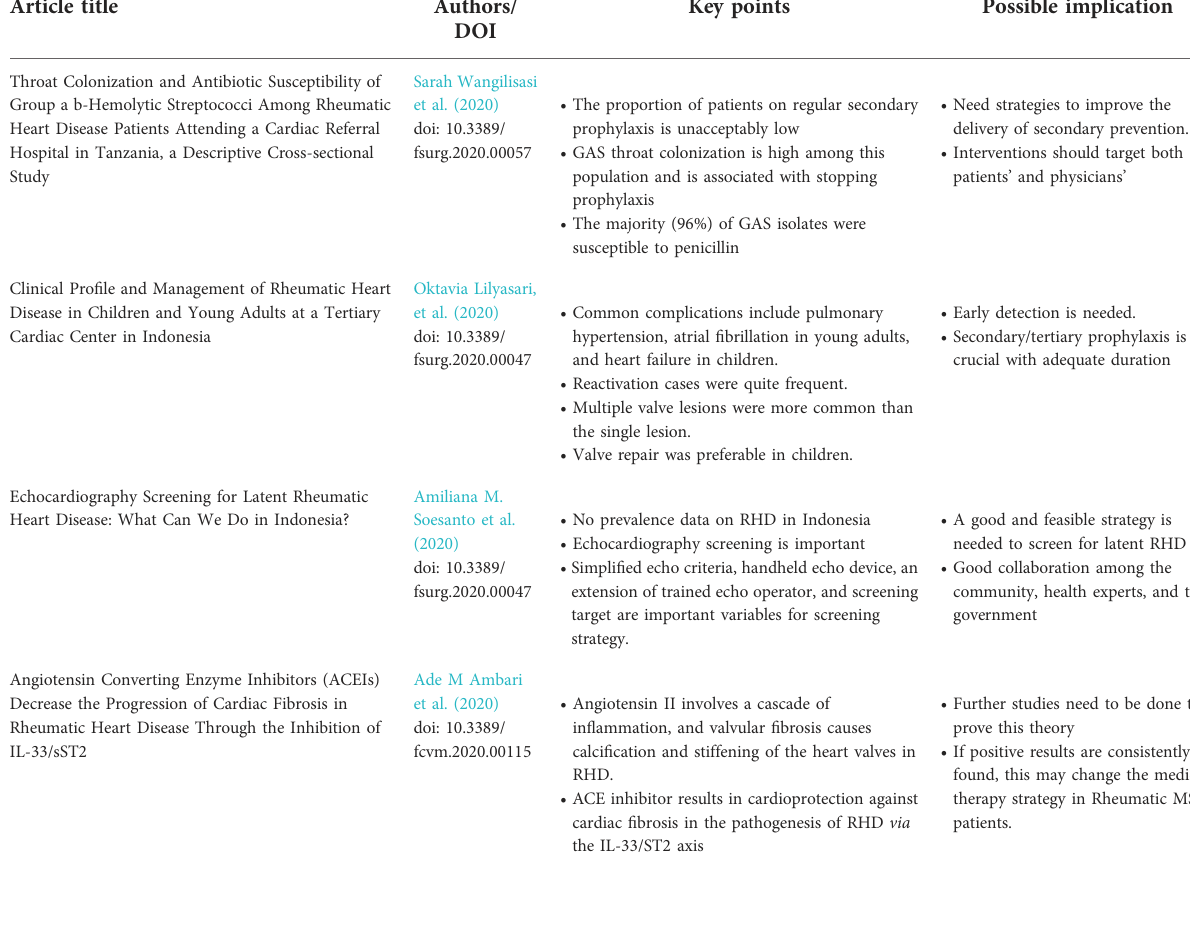
TABLE 1 Summary of the research topic “ New Challenges with the Management of Rheumatic Heart Disease.